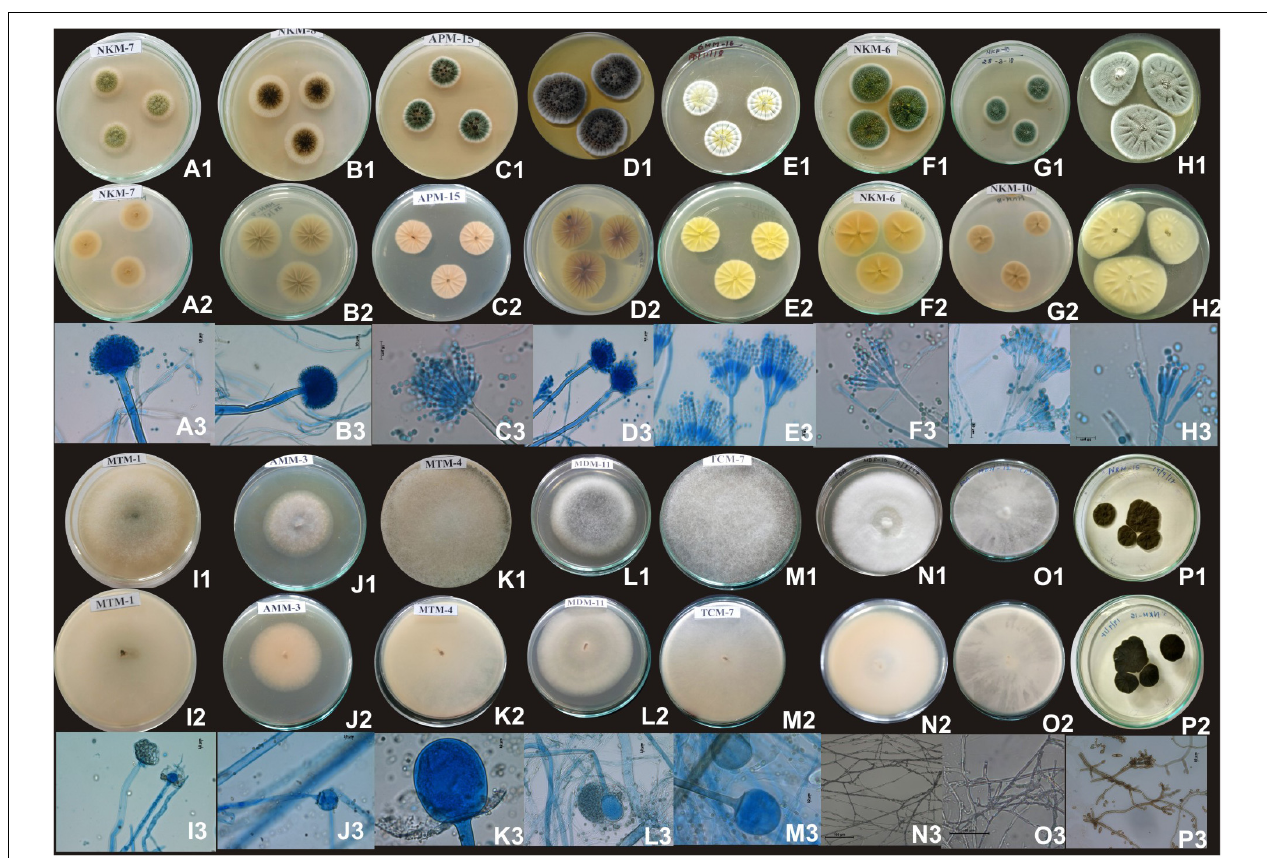
FIGURE 5 | Images of colony morphology and microscopic features of filamentous molds that grew on MEA media: Aspergillus flavus colonies top (A1) , reverse (A2) , Conidiophores (A3) ; Aspergillus niger colonies top (B1) , reverse (B2) , mature conidia globose conidial head contain conidia (B3) ; Aspergillus sydowii colonies top (C1) , reverse (C2) , mature conidiophore with vesicle bearing conidiogenous metulae and phailides (biserate) (C3) ; Aspergillus versicolor colonies top (D1) , reverse (D2) , conidial heads supported vesicles with which are biseriate with metulae about the same size of philiades (D3) ; Penicillium chrysogenum colonies top (E1) , reverse (E2) , smooth-walled conidiophores stipes (150–280 µ m) and biverticillate (E3) ; Penicillium citrinum colonies top (F1) , reverse (F2) , conidiophores stipes (150–280 µ m) and biverticillate, phialides ampuliform (flask-shaped) (F3) ; Penicillium oxalicum colonies top (G1) , reverse (G2) , mature conidiophores monoverticillate, or biverticillate and asymmetrical, phialides were cylindrical; Penicillium polonicum colonies top (H1) , reverse (H2) , conidiophore were terverticillate, phialides (H) ; Mucor circinelloides colonies top (I1) , reverse (I2) , mature sporangiosphores contain sporangiospores (I3) ; Mucor indicus colonies top (J1) , reverse (J2) , mature sporangiosphores contain sporangiospores (J3) ; Rhizopus delemar colonies top (K1) , reverse (K2) , globose sporangium (K3) ; Rhizopus oryzae colonies top (L1) , reverse (L2) , sporangiophores were usually straight, mostly 10 ∼ 20 µ m (L3) ; Rhizopus microsporus colonies top (M1) , reverse (M2) , sporangia globose, smooth and released spore (M3) ; Trametes hirsuta colonies top (N1) , reverse (N2) , hyphal structure (N3) ; Bjerkandera adusta colonies top (O1) , reverse (O2) , dichotomously branched hyphae (O3) ; Cladosporium parahalotolerans colonies top (P1) , reverse (P2) , conidiophores and conidial chain (P3)